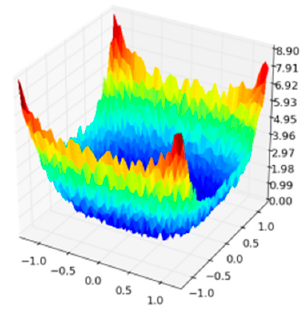
Figure 3. Quartic Function.